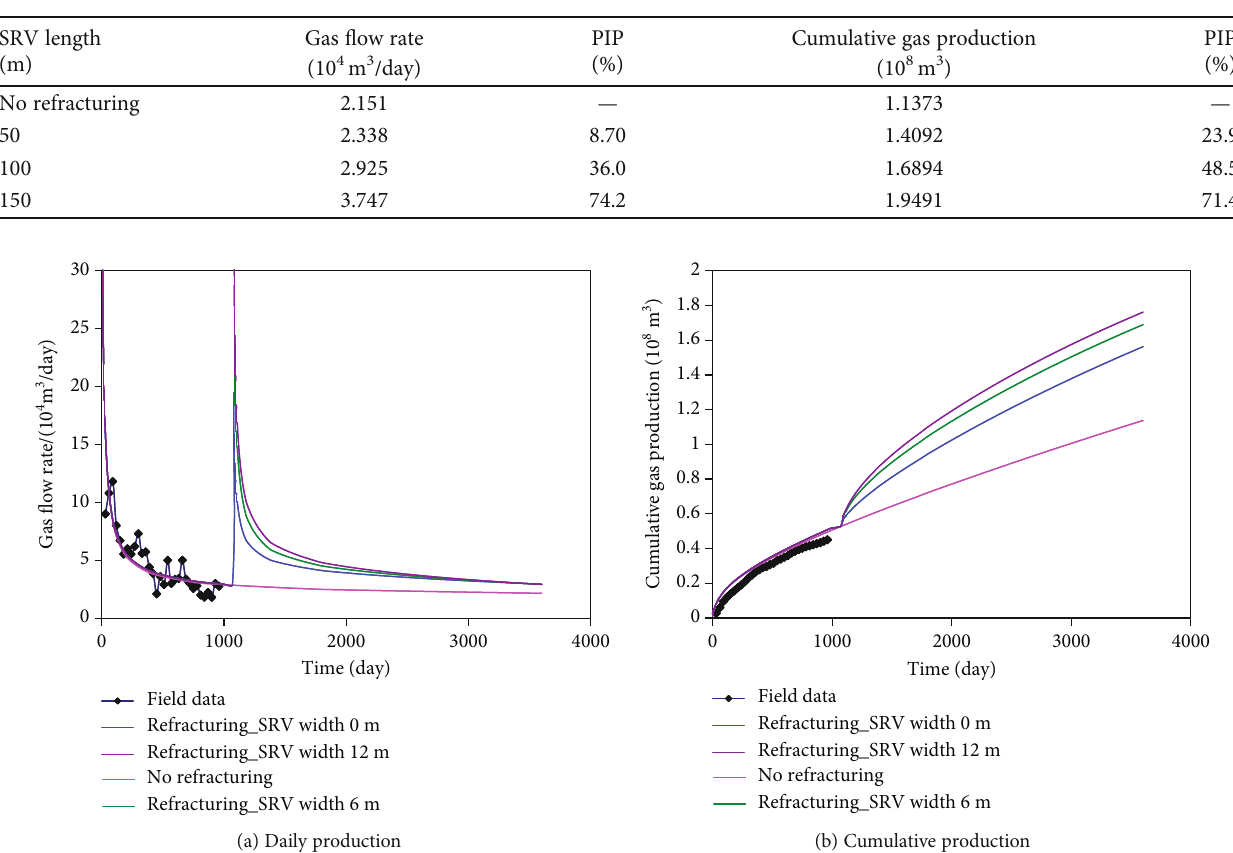
Figure 17: E ff ect of the new SRV length on daily and cumulative productions. Table 7: Production increase percentage after 7 years corresponding to di ff erent SRV lengths of refractured new fracture.